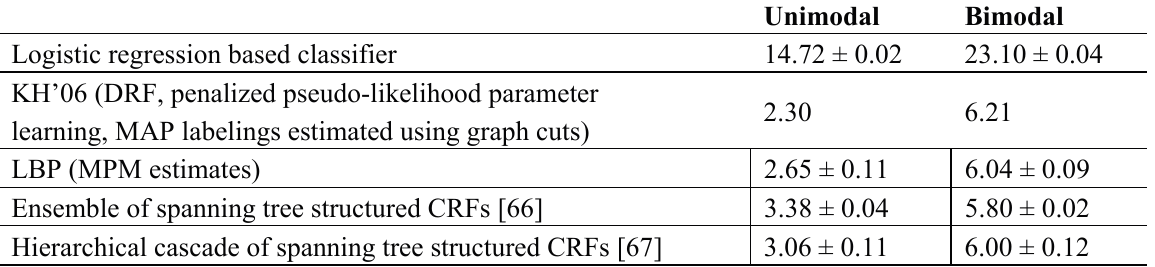
Table 2. Pixelwise classification error (%) for binary denoising task. KH’06 stands for the results published in [9]. Comparisons to logistic classifier and grid-structured CRF model with loopy belief propagation inference (LBP) are also shown. The averaging was done over five different runs each on 160 test samples; mean ± standard deviation is